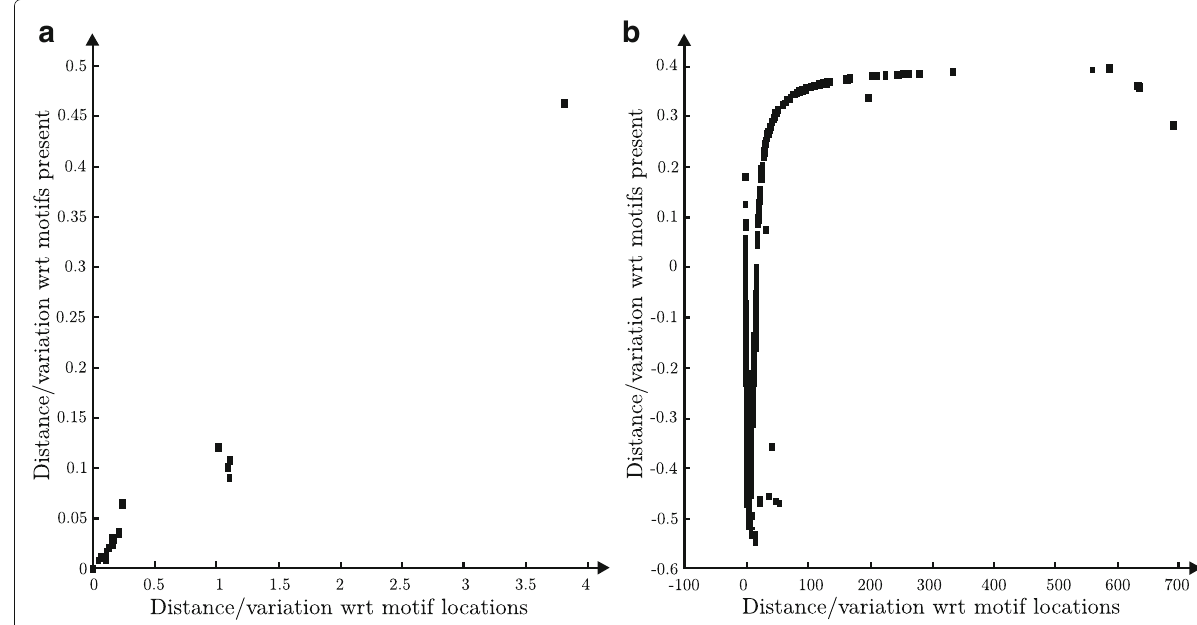
Fig. 5 Sequence space for two applications a ftpd (File Transfer Protocol Daemon) and b lpr (Line PRinter) [26]